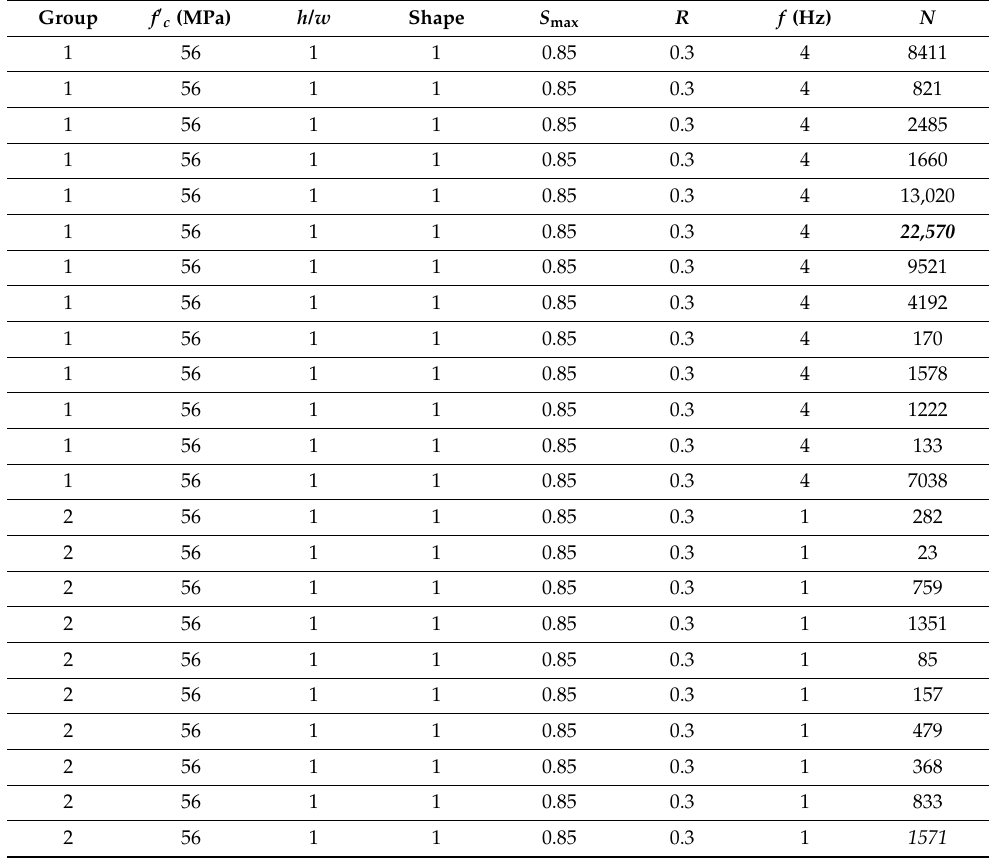
Table 4. Outlier identified in grouped